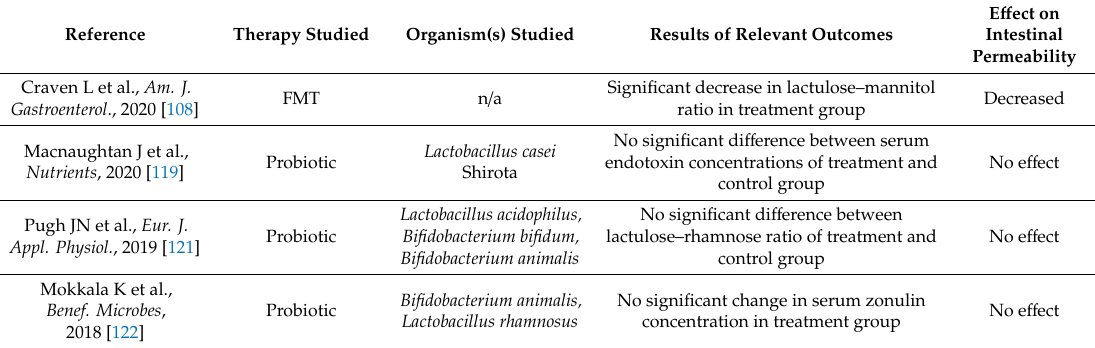
Table 1. Examples of recent randomised-controlled trials that study the e ff ect of non-dietary therapies on the intestinal